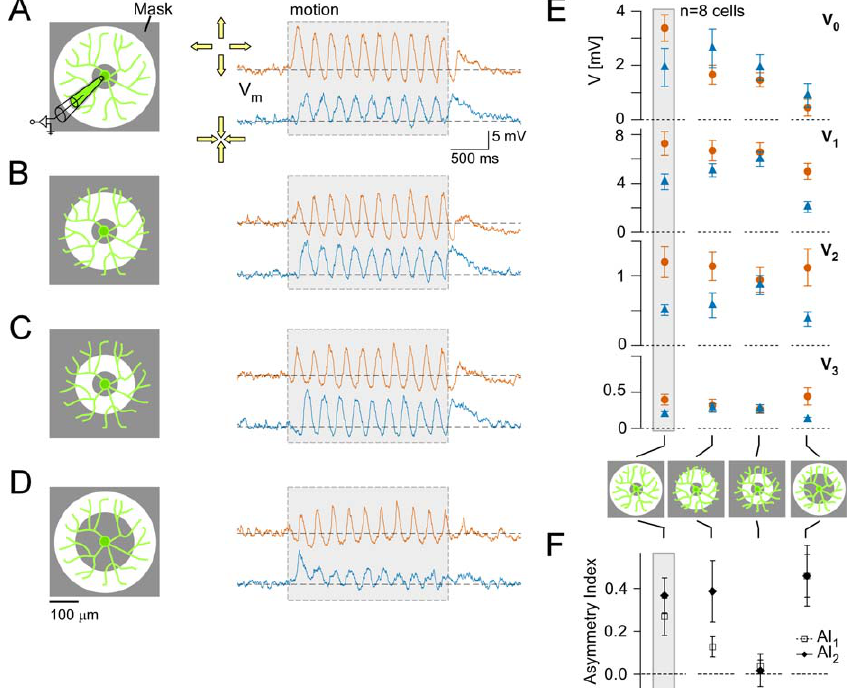
Figure 8. Stimulus-Coverage Dependence (A–D) Voltage responses to circular wave stimuli (3 Hz; 72% contrast; period: 192 l m) that cover different areas of the SAC dendritic field (see Materials and Methods; averages of three trials; CF motion in orange, CP in blue). Left column: stimulus masks, white areas indicate where the moving stimulus is presented ( V Rest ¼(cid:2) 62 mV). (E) Amplitudes of DC ( V 0 ) , fundamental ( V 1 ) , and harmonics ( V 2 and V 3 ) plotted versus mask configuration (averages of eight cells). Leftmost data (gray box): ‘‘ standard ’’ stimulus from (A). (F) AI s for V 1 (open squares) and V 2 (filled diamonds) from (E). For statistics, see Table 1.